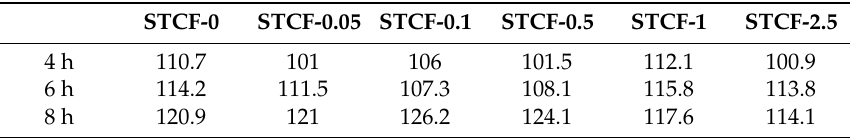
Table 5. Wetting performance of composite films coated on wood with differing Fe 3+ doping as well as with different immersion